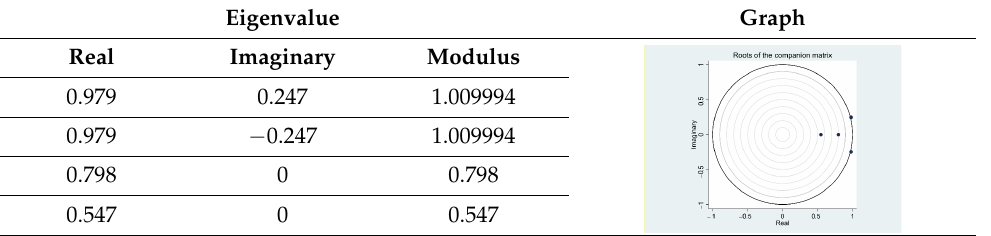
Table 6. Eigenvalue stability test.